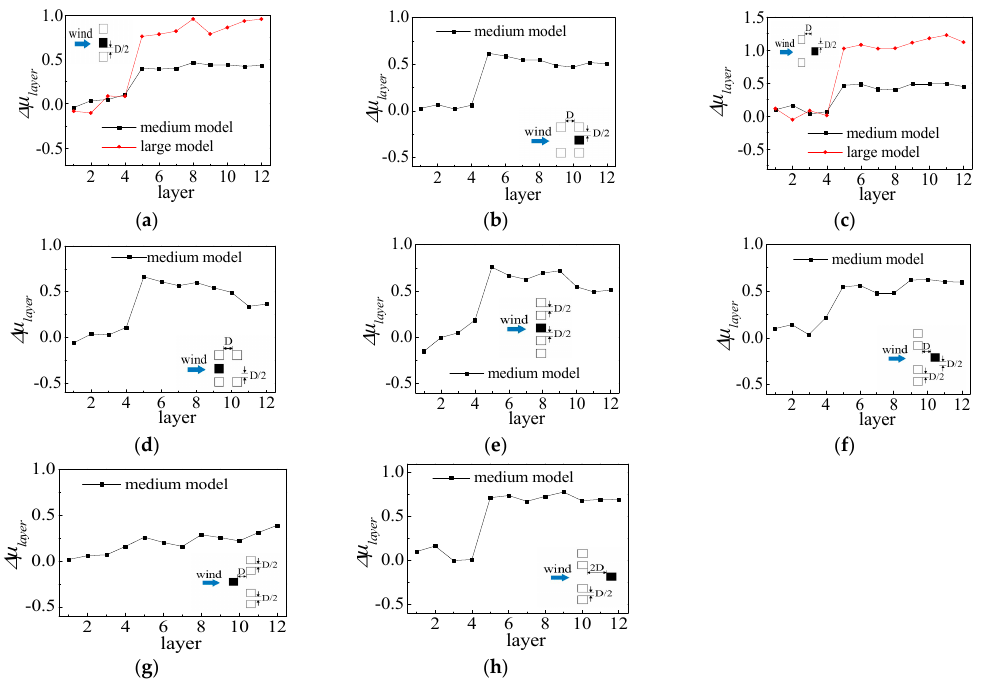
Figure 18. The relative error of the mean pressure coefficient of layers. ( a ) test condition 1; ( b ) test condition 2; ( c ) test condition 3; ( d ) test condition 4; ( e ) test condition 5; ( f ) test condition 6; ( g ) test condition 7; ( h ) test condition 8.